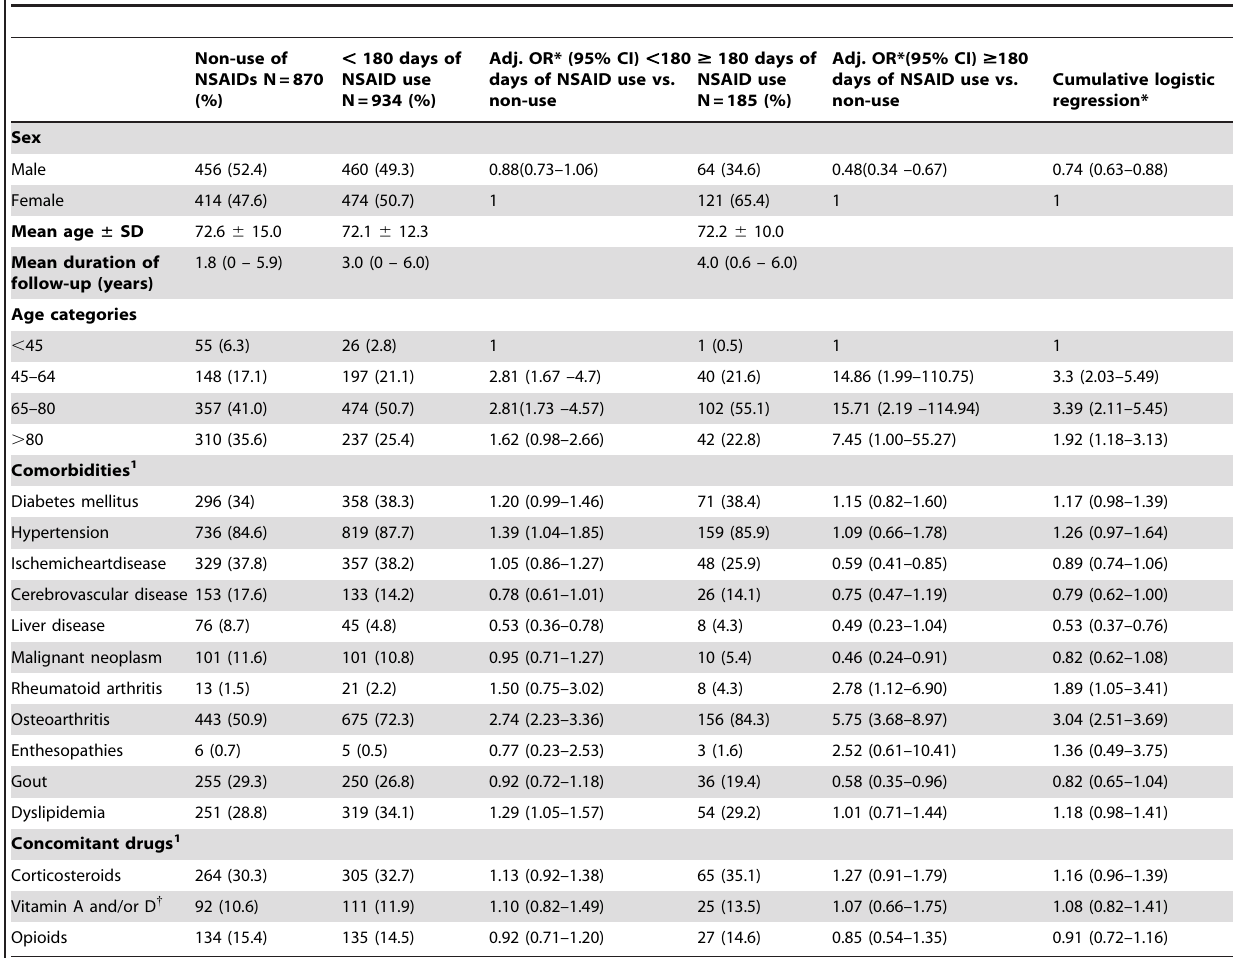
Table 1. Characteristics of incident CKD patients, stratified by cumulative use of NSAIDs during the follow-up, and results from ordinary and cumulative logistic